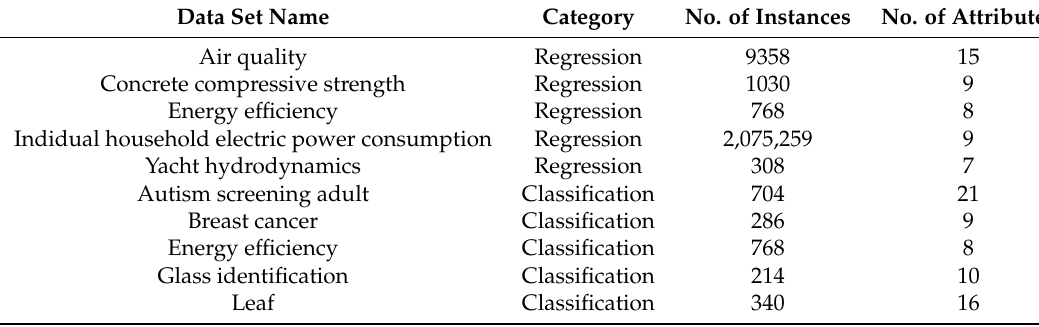
Table 1. Number of instances and attributes for each data set used to test classification and